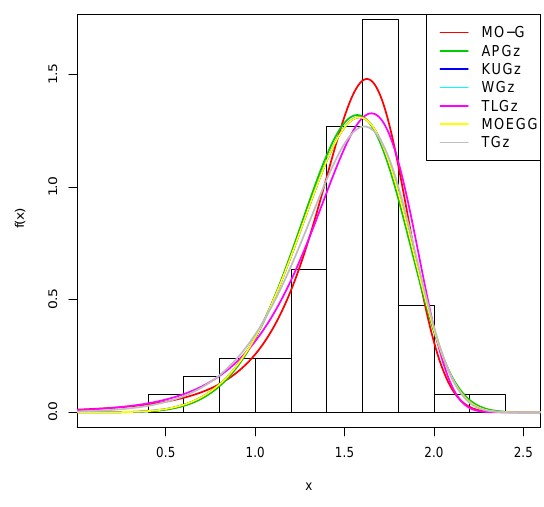
Figure 5 – The plots of estimated MO-G